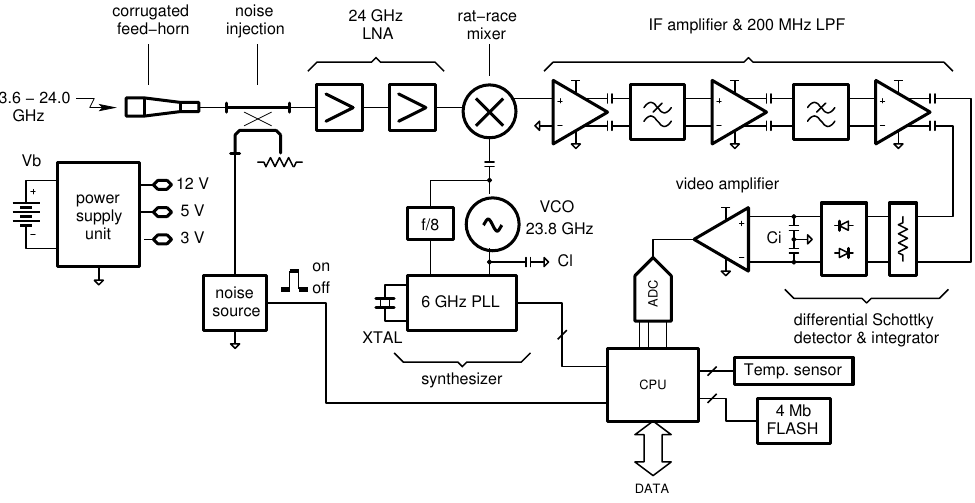
Figure 6. Architecture of the developed single-board, 24-GHz, Noise Adding Radiometer (NAR). For low-cost applications, the calibration circuitry of Figure 2 is simplified by removing the Dicke switch. This means that only the gain is corrected. The radiometric offset is less important since, in fire detection, the information is carried by the radiometric contrast (brightness temperature